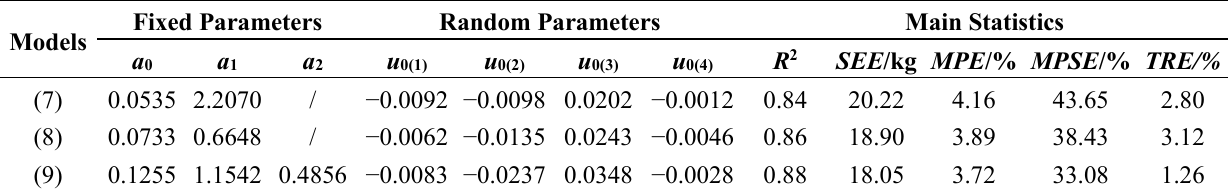
Table 4. The fitting results of nonlinear mixed-effects models of crown